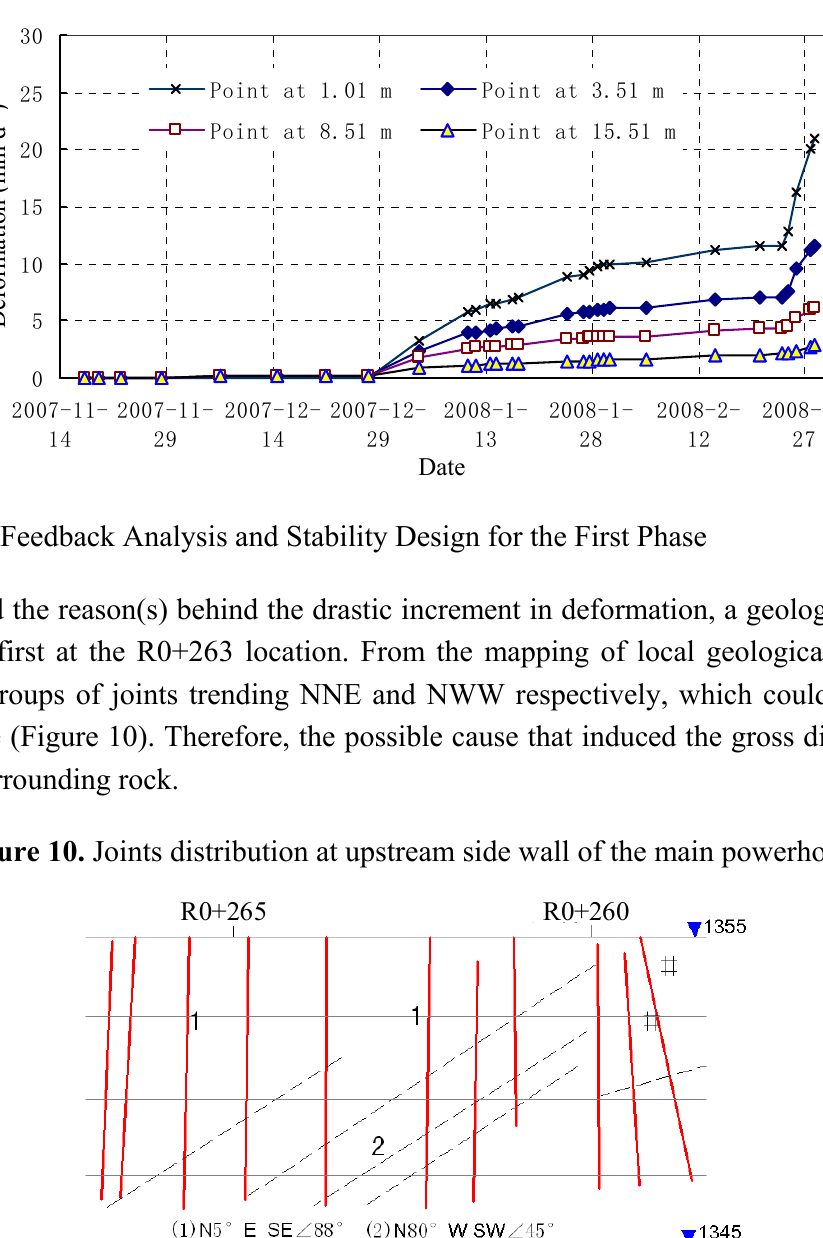
Figure 9. Deformation curve inspected by multi points extensometer No. Mcf0+263 − 1 at R0+263 of the powerhouse excavation.